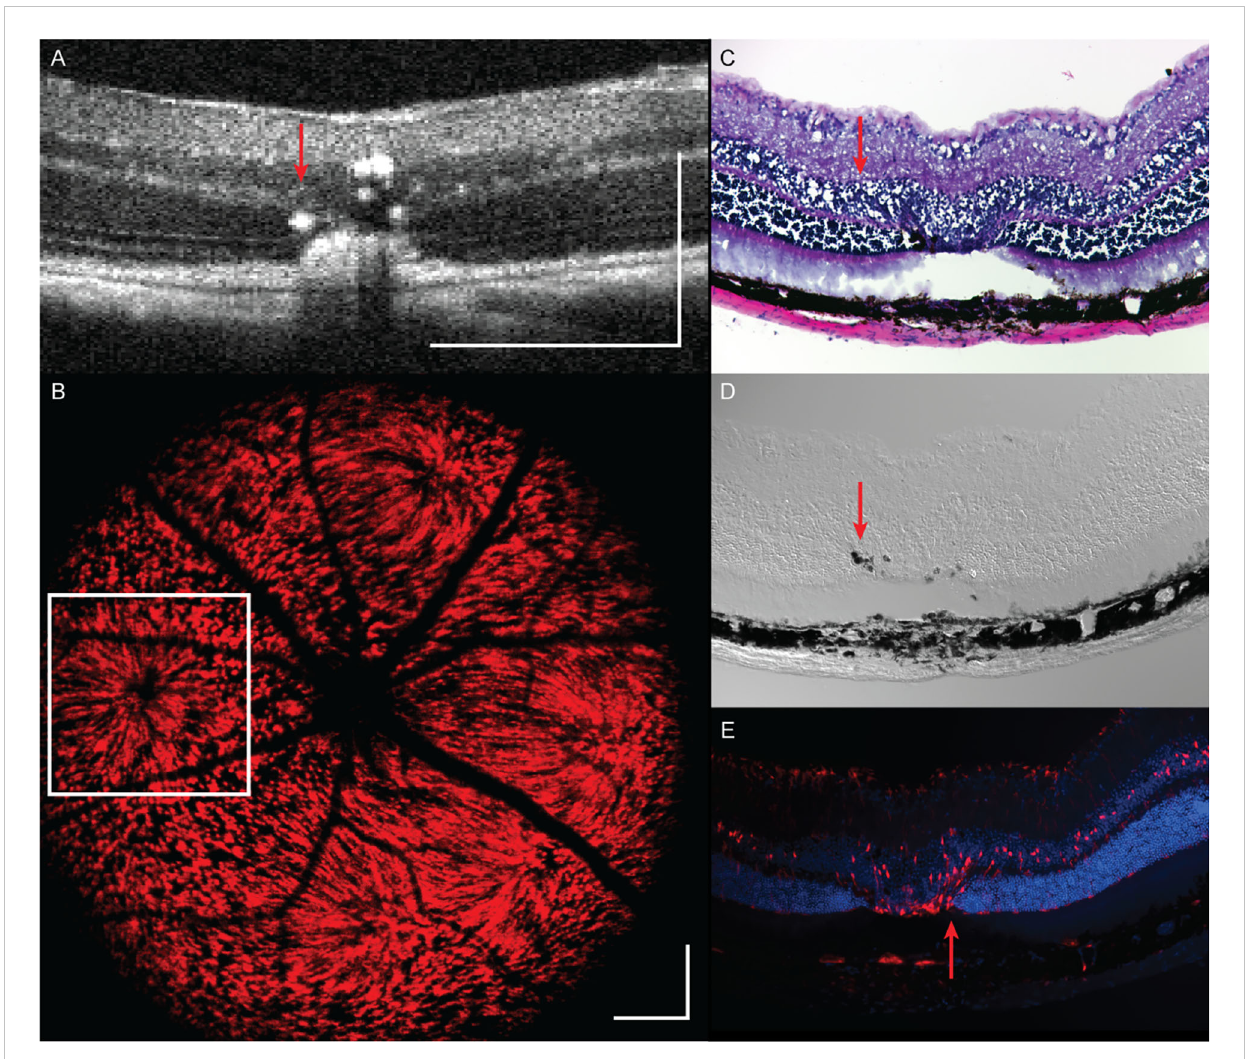
FIGURE 8 Retinal structural changes at 21 days following a single 20 mW, 300 ms duration laser pulse as assessed by (A) OCT, (B) SLO, (C) H&amp;E histology, (D) DIC microscopy, and (E) epi fl uorescence. Scale bar: 250 µm. Red arrow: hyper-pigmented cells and debris within laser